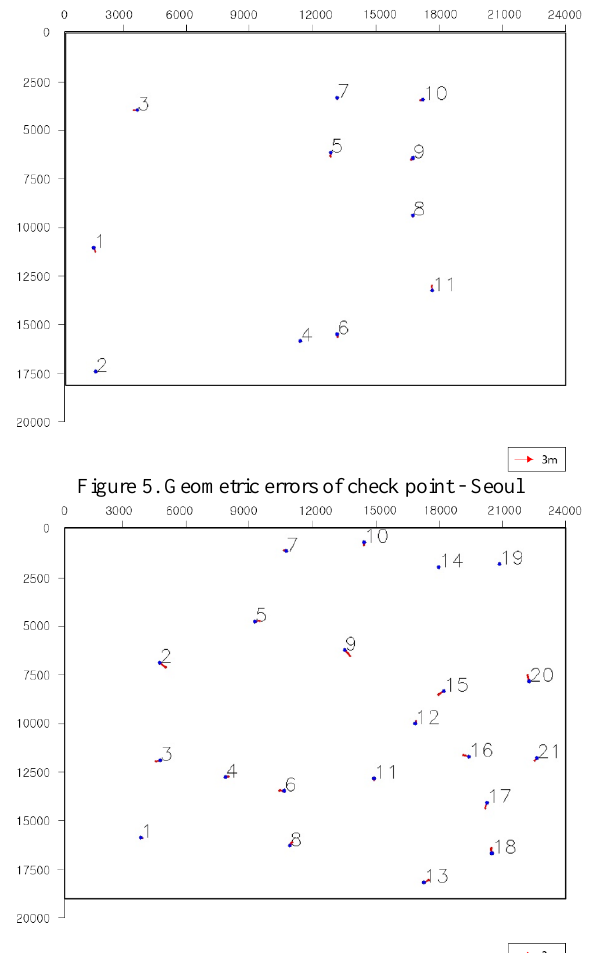
Figure 6. Geometric errors of check point – Pyeongyang.